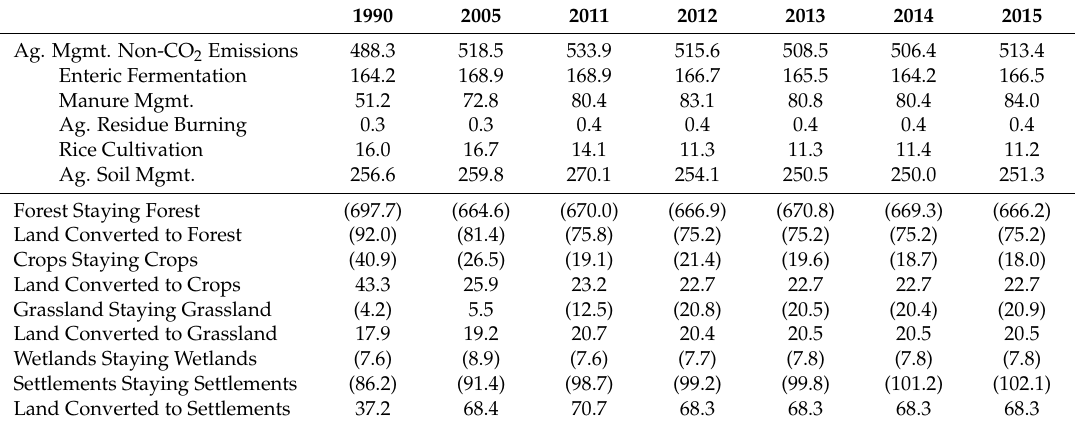
Table 1. Historical U.S. emissions and sequestration (in parentheses) from forest and agricultural sectors. All units expressed in units of TgCO 2 e/yr. Source